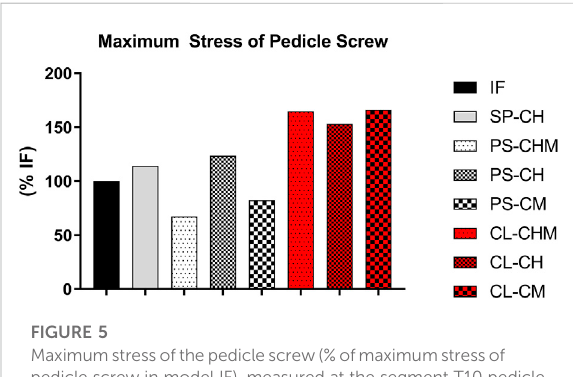
FIGURE 5 Maximumstressofthepediclescrew(%ofmaximumstressof pedicle screw in model IF), measured at the segment T10 pedicle screw for IF, SP-CH, PS-CHM, PS-CH, PS-CM, CL-CHM, CL-CH, and CL-CM models.